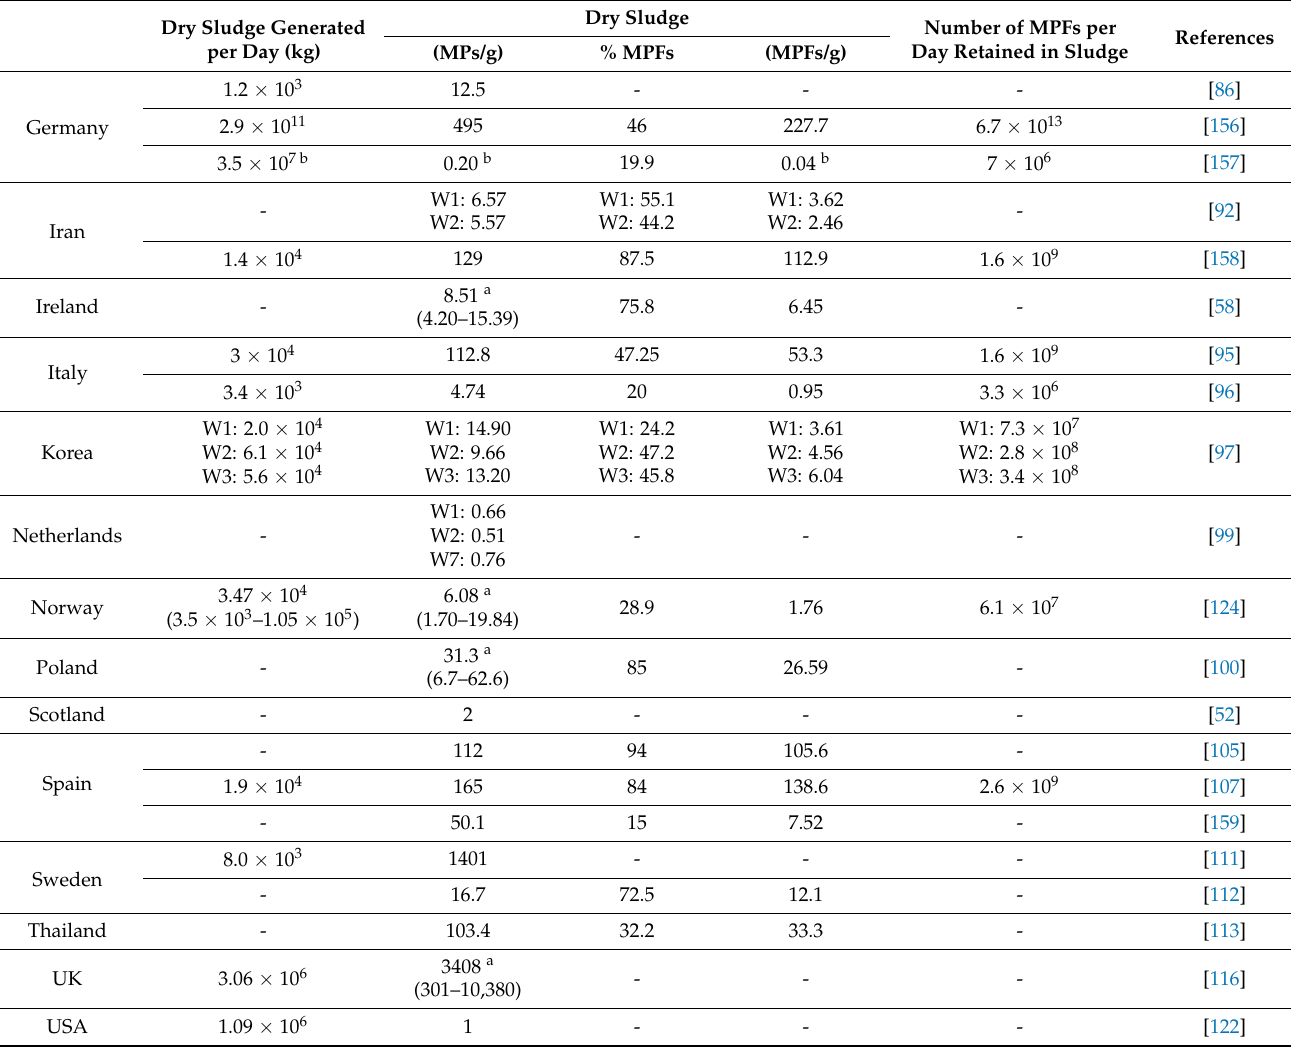
a Data obtained from the average values of different WWTPs (W ≥ 6) analysed in the study. (MPs/g) and (MPFs/g) are shown as the mean value, whereas in parentheses the minimum and maximum values found are reported. b Values are expressed in L − 1 . Parts A and B correspond to two parallel treatment systems within the same